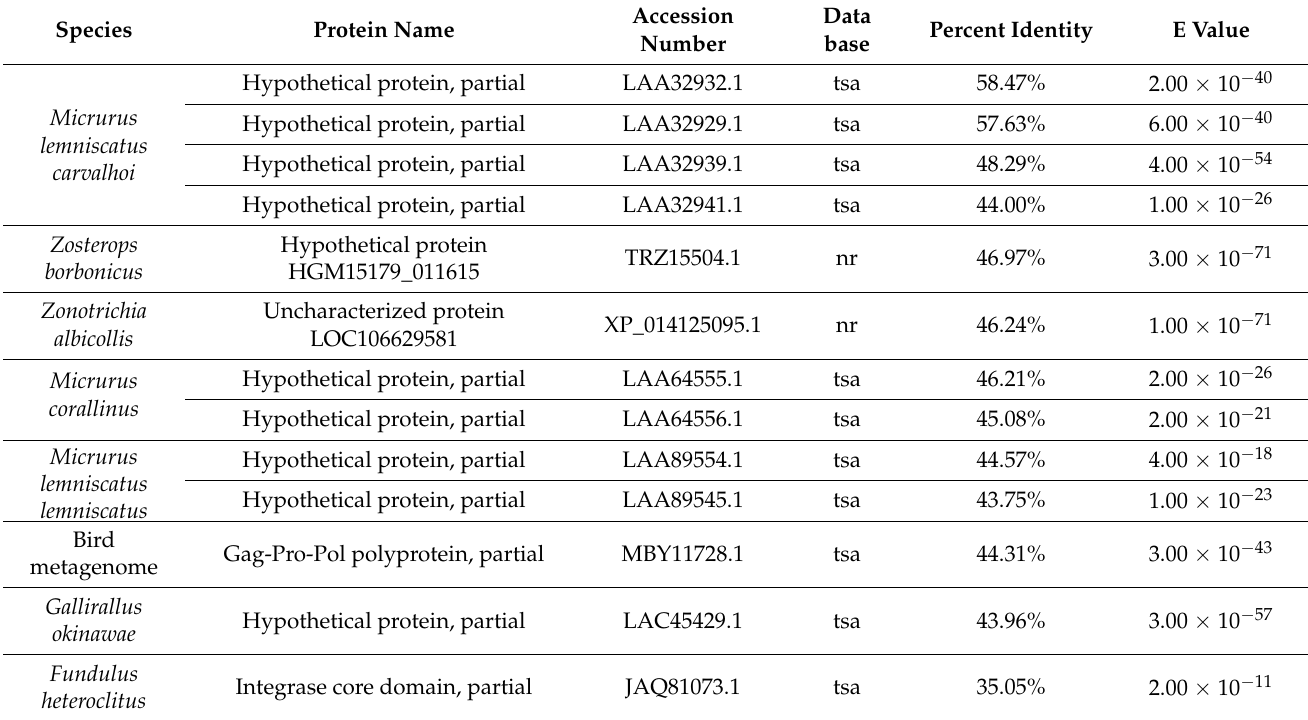
Table A3. Euteleostomi genomes with similarity to ERVK integrase based on BLASTp searches.